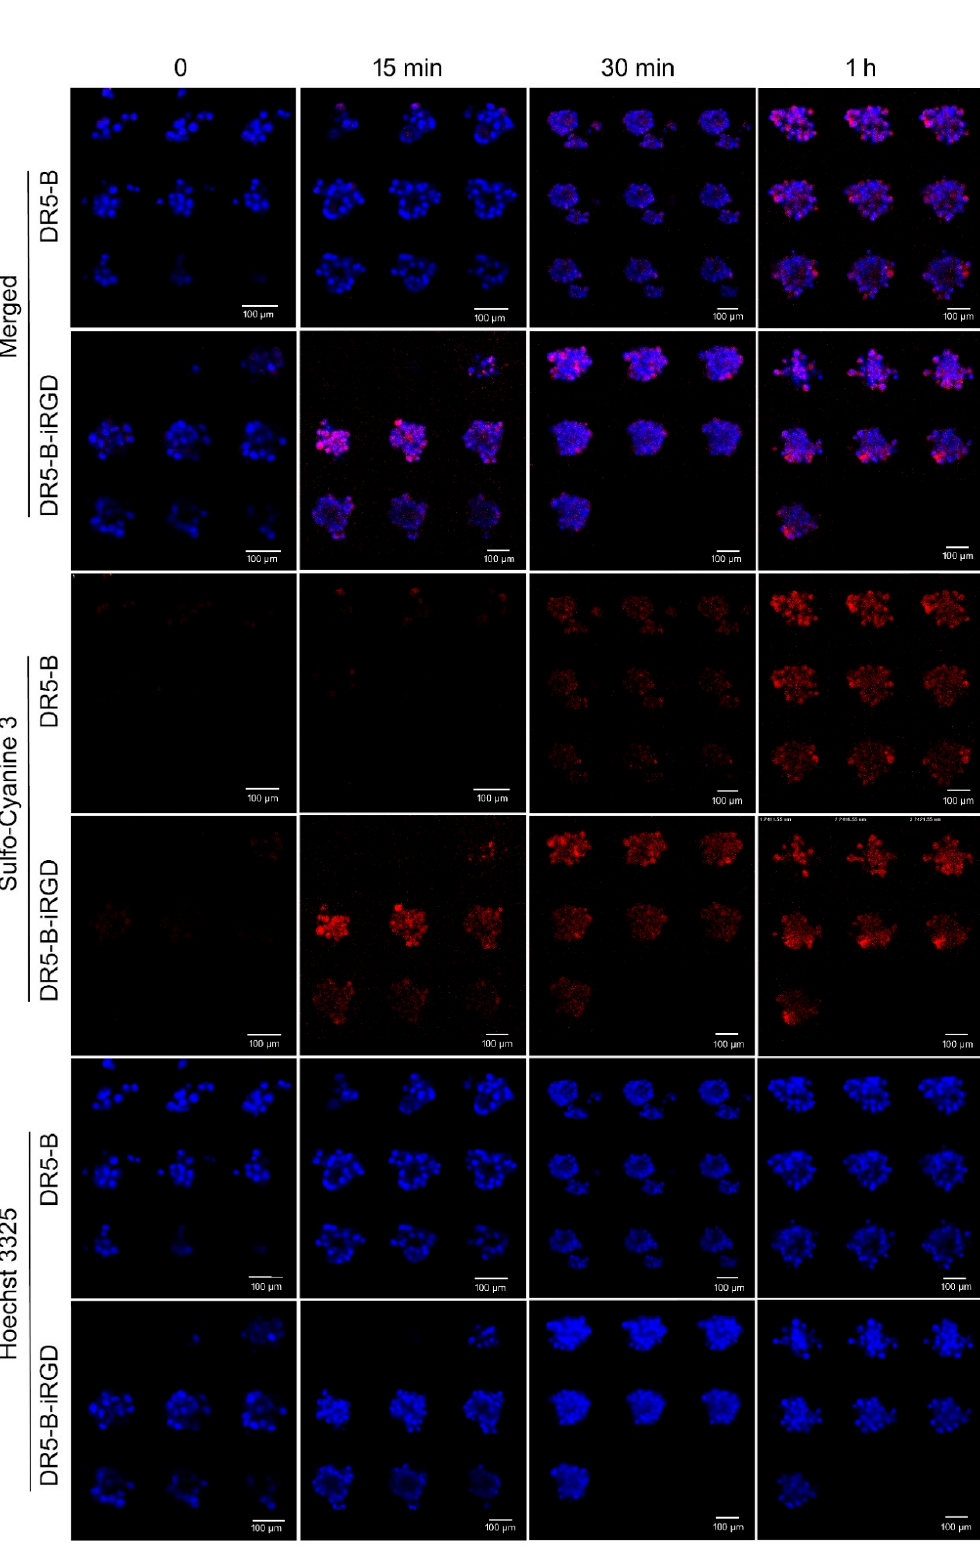
Figure 5. Penetration of the DR5-B and DR5-B-iRGD into multicellular tumor spheroids of U-87 human glioblastoma cell line. Confocal laser scanning microscopy Z-stack images of U-87 human glioblastoma multicellular spheroids after 15 min, 30 min, and 1 h incubation with 5 µM of DR5-B or DR5-B-iRGD. DR5-B and DR5-B-iRGD are in red (sulfo-Cy3); cell nuclei are in blue (Hoechst 33258). Scale bar is 100 µm; a step for Z-stack images is 5–15 µm.